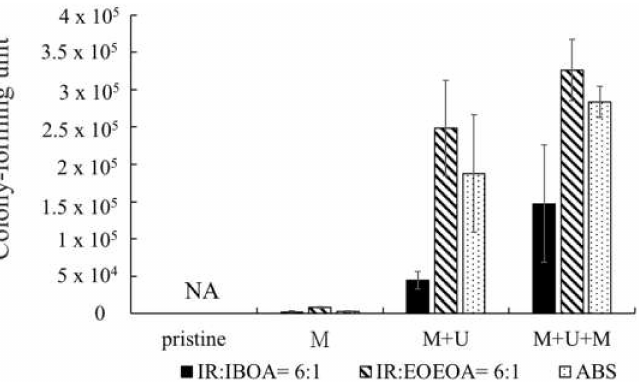
Figure 6. Different method of culturing H. pylori on resin and ABS under the pH 2 environment. M means mucin coating, M + U means mucin/urea coating, and M + U + M means mucin/urea/mucin coating. All the surfaces were treated by plasma before mucin and urea